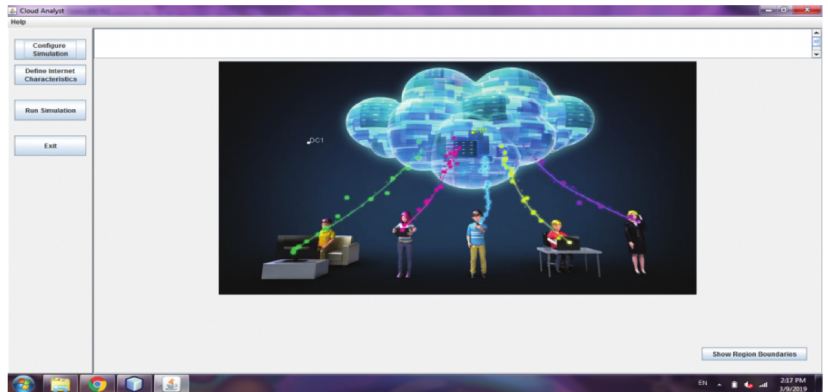
Figure 4: Cloud Simulation Window.